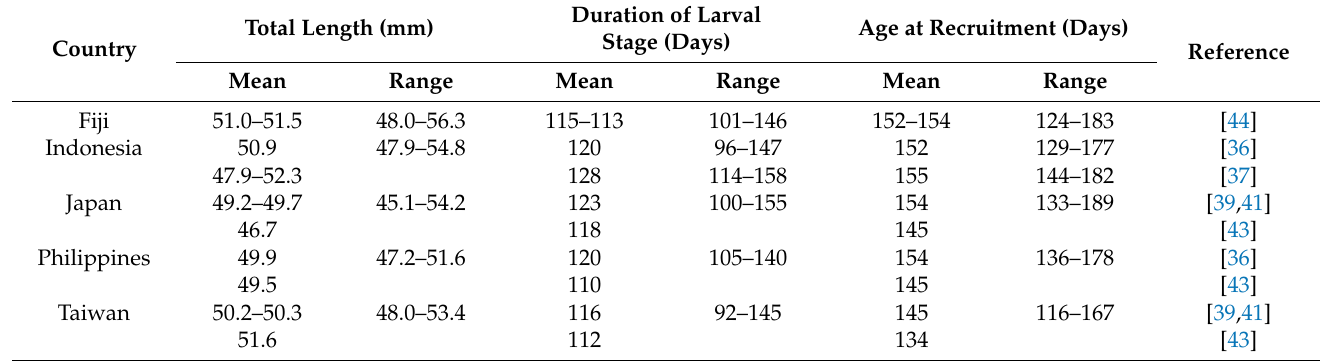
Table 2. Early life history characteristics of Anguilla marmorata recruited to Pacific